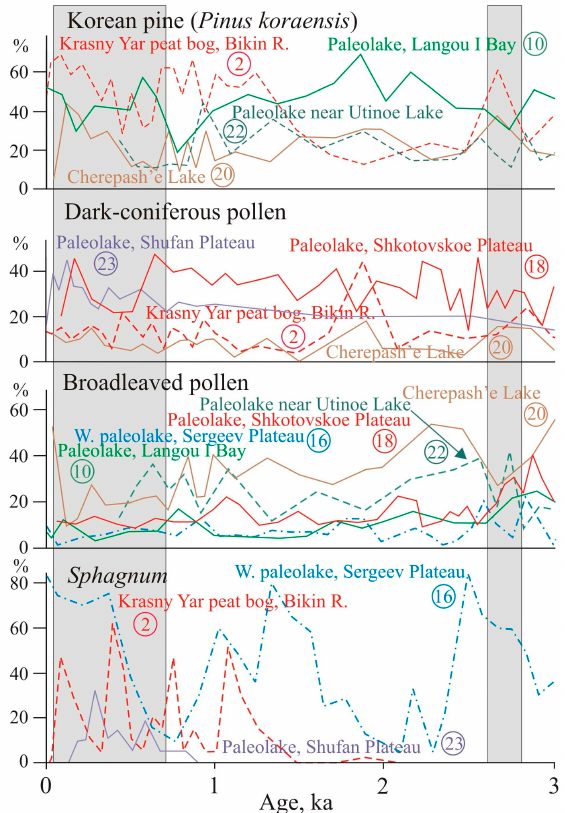
Figure 4. Comparison of results for pollen and Sphagnum remains from peat bog and paleolake sequences on the mainland. Grey bars indicate 2800–2600 year BP cold event and the LIA. Numbers of sites according to Figure 2.